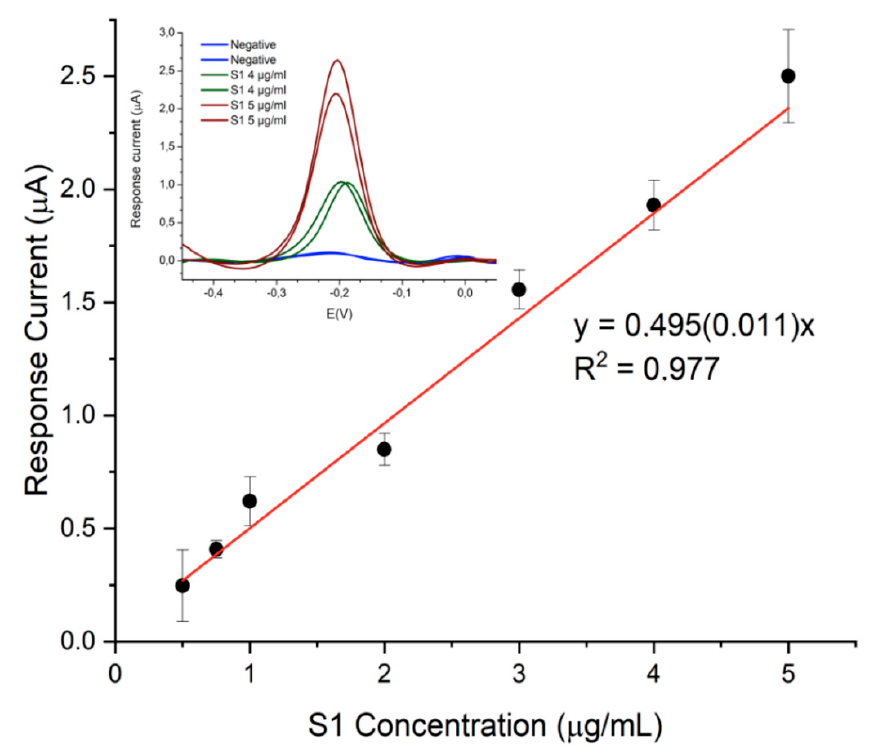
Figure 5. Calibration curve of the immunosensor for SARS-CoV-2 S1 protein. Inset: DPV responses acquired using the portable potentiostat.